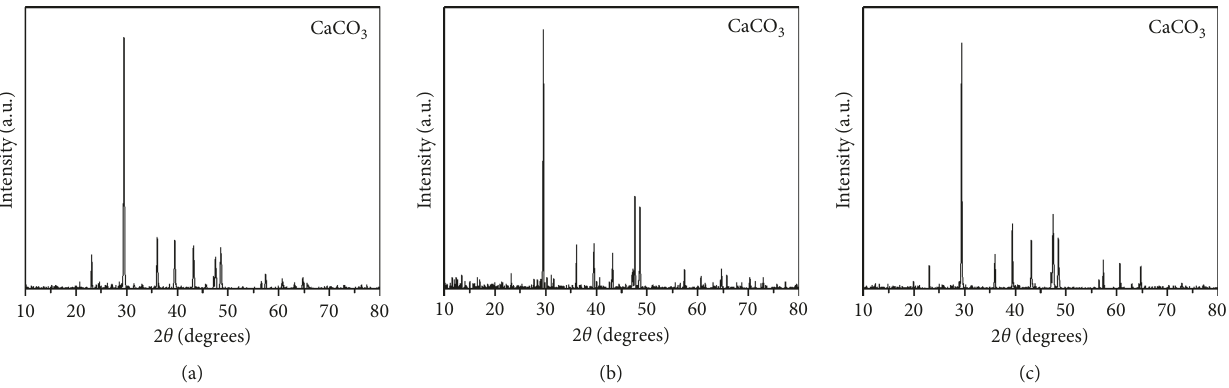
Figure 2: Diffractograms of the crystalline samples. (a) Sample 1. (b) Sample 2. (c) Sample